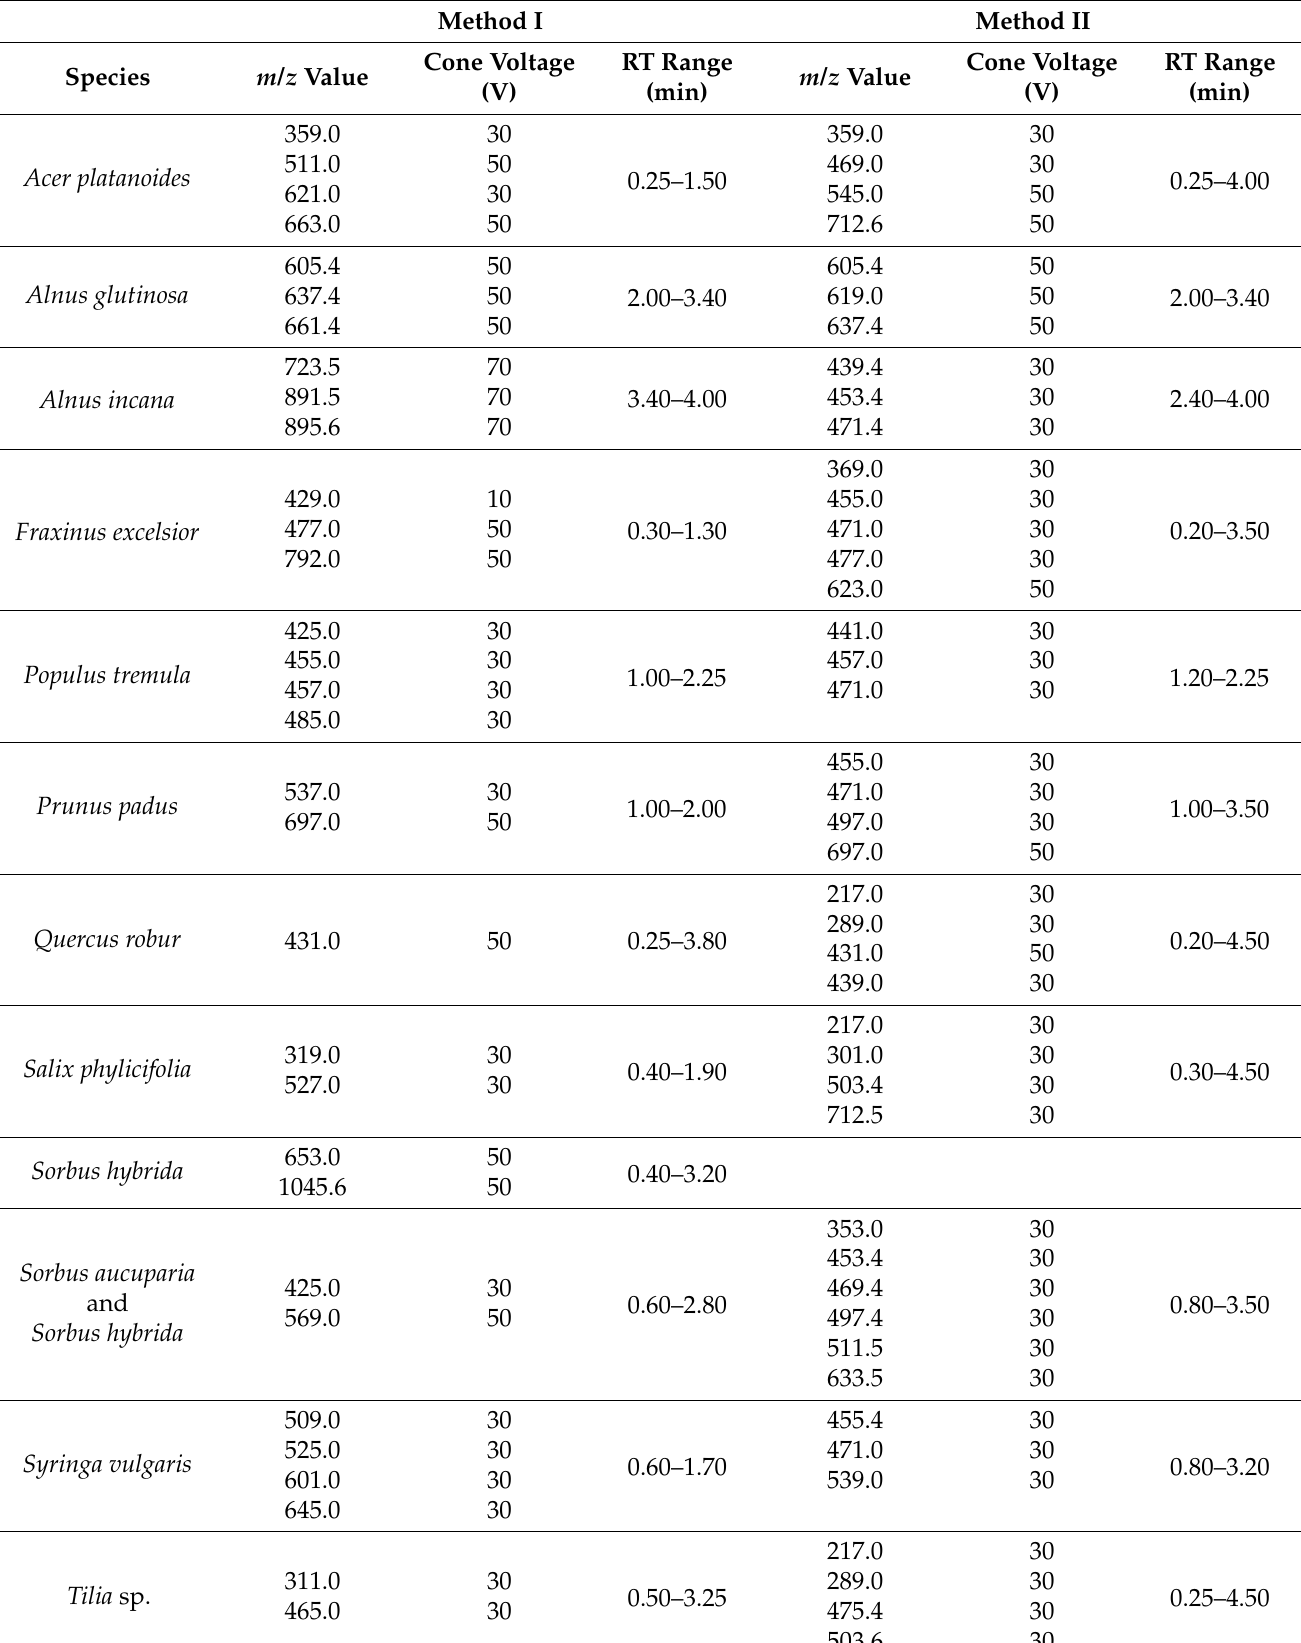
Table 3. Selected ion recording parameters for the LC–MS fingerprinting